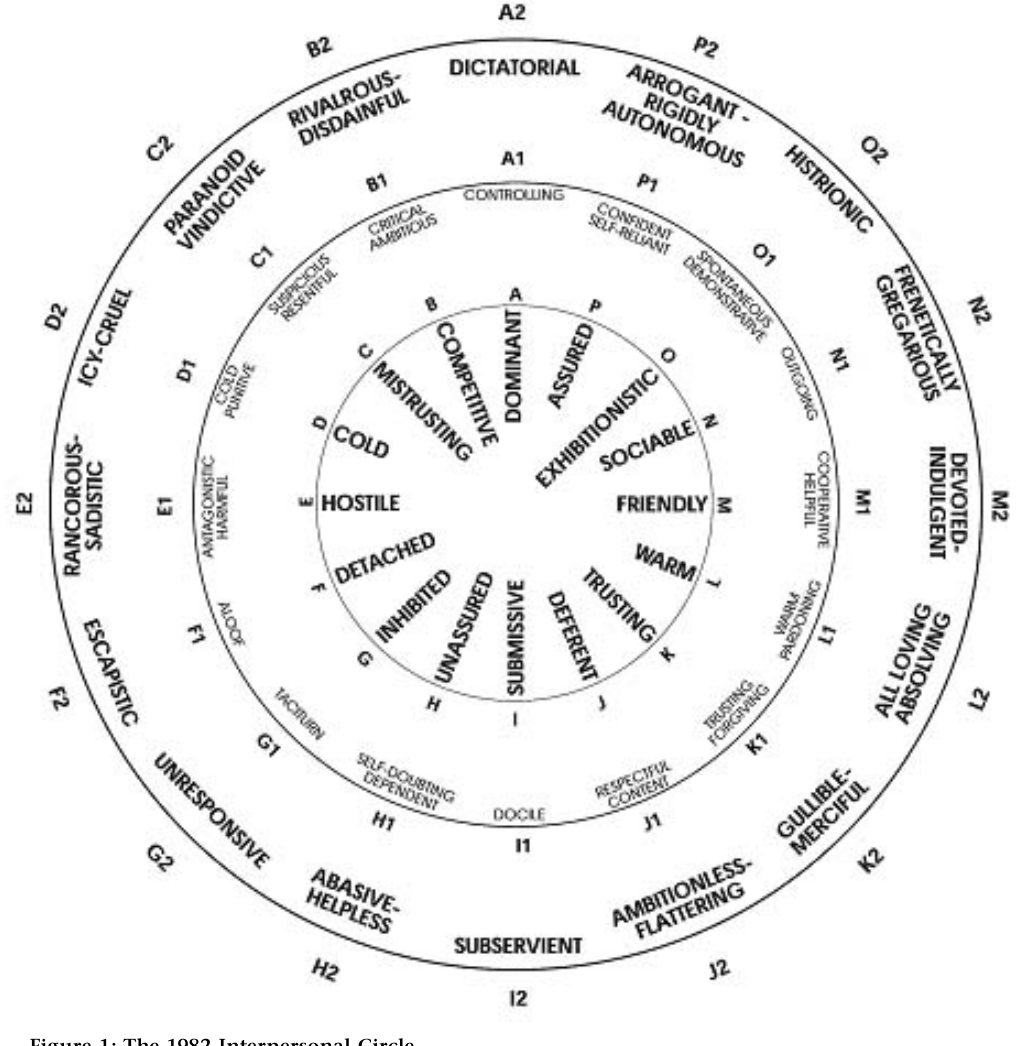
Figure 1: The 1982 Interpersonal